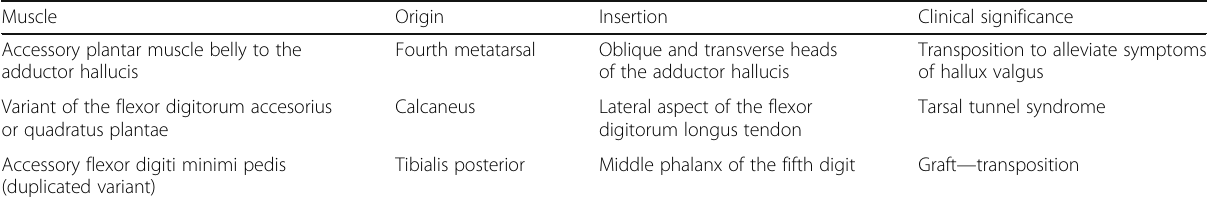
Table 3 Origin, insertion, and clinical significance of rare accessory muscles around the mid and